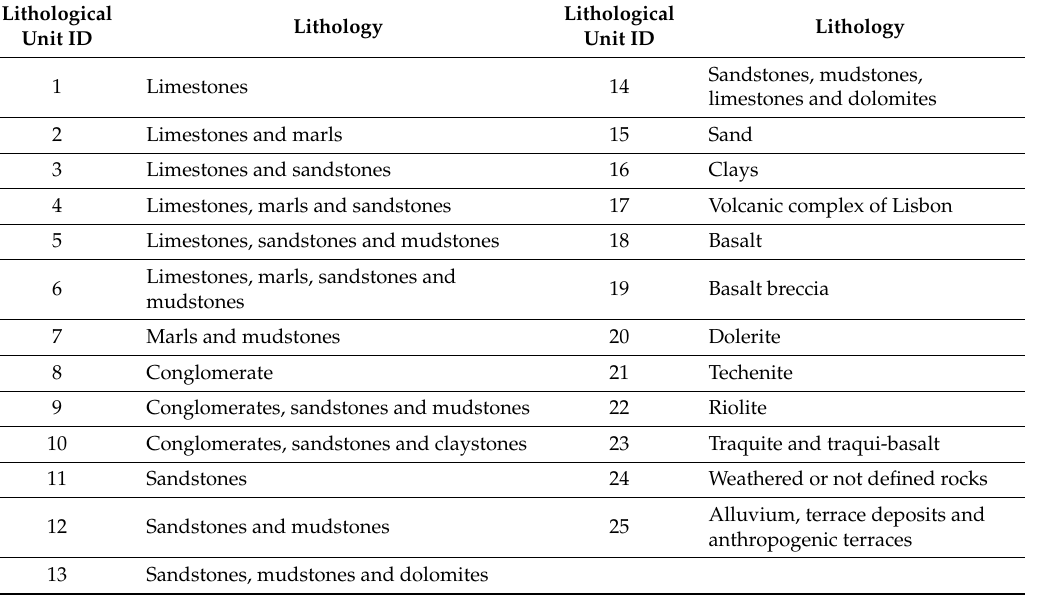
Table 2. Lithological Units.